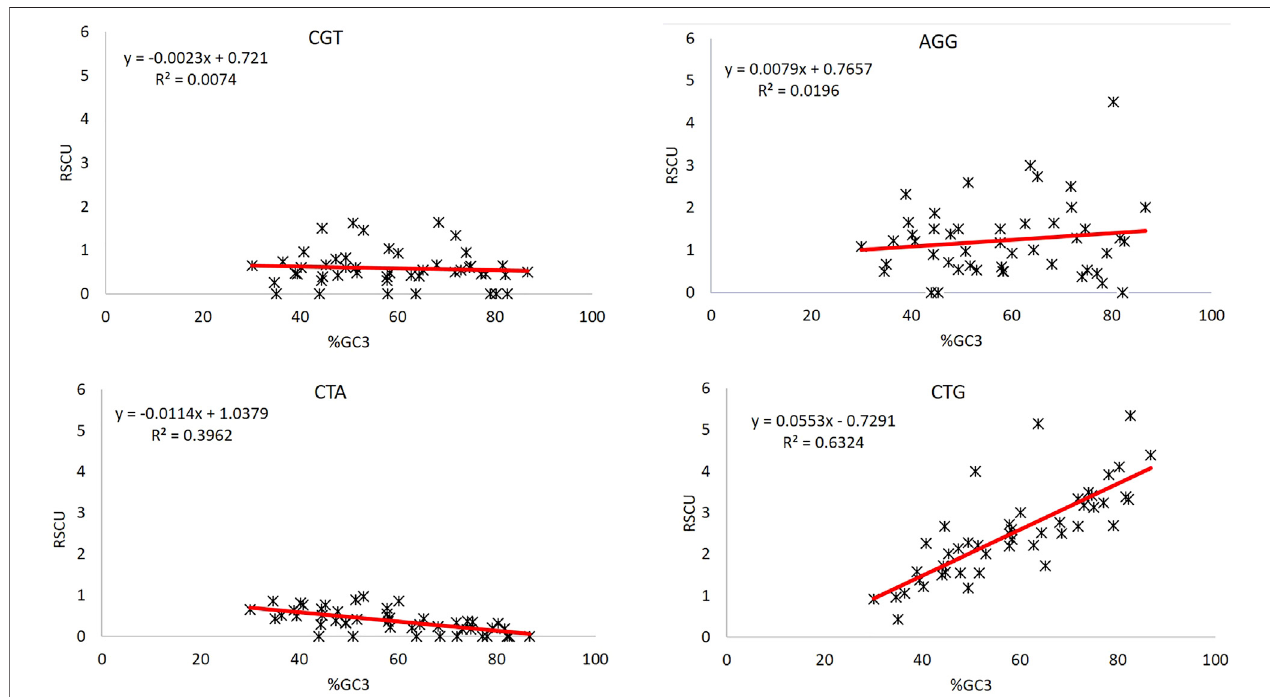
FIGURE 4 | Regression analysis between GC3 and RSCU of codons CGT, AGG, CTA, and CTG.